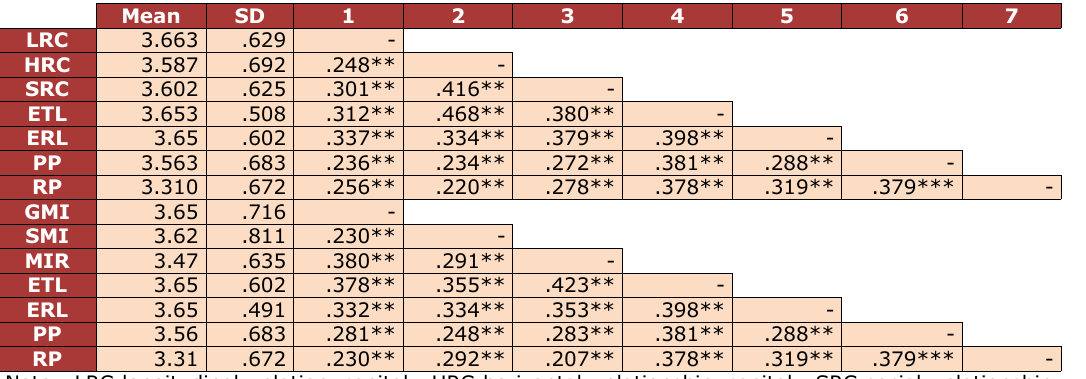
Table 2. Correlations Matrix for